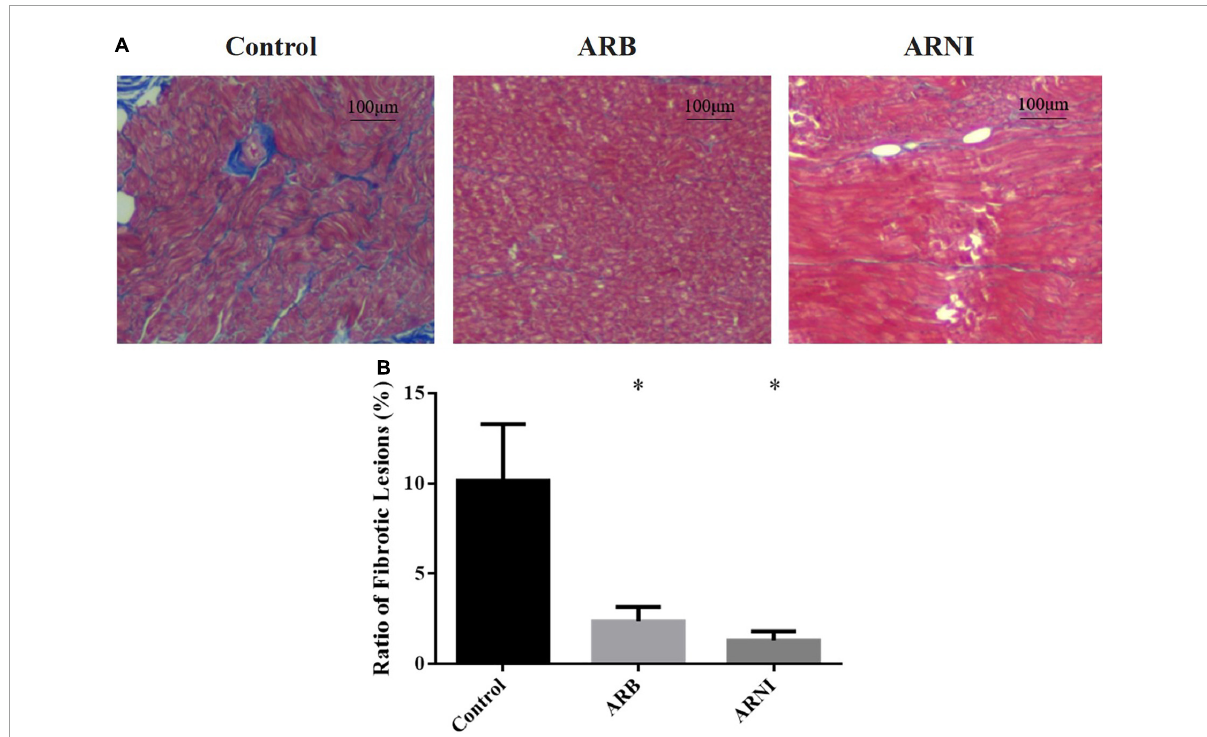
FIGURE2 Pathological staining of left atrium. (A) Masson staining (4 × 10 magnification) renders myocardial cells red and collagen blue. The left atrium tissue in Control group had more fibrotic area compared to the other groups. (B) Ratio of fibrotic lesions in left atrium. ∗ P < 0.05 compared to the Control